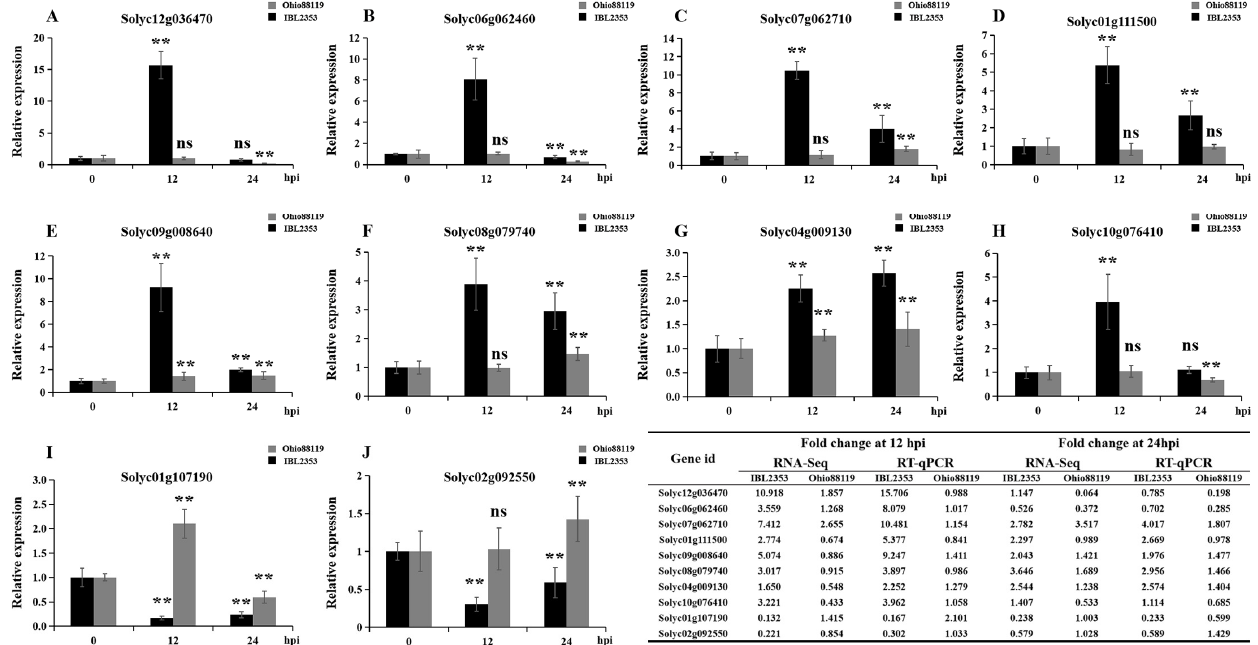
Figure 7. RT-qPCR analysis of 10 selected DEGs. ( A – J ) display the relative expression values of 10 selected genes in Cm -susceptible and Cm -resistant tomato lines at two time-points, respectively. The transcript expression level of each gene at 0 hpi was set as 1.0. ** denotes very significant differences compared to 0 hpi based on independent-samples t -test ( p < 0.01), ns denotes no significant differences compared to 0 hpi ( p > 0.05). The table displays the fold change comparison between the RNA-Seq analysis and RT-qPCR validation.